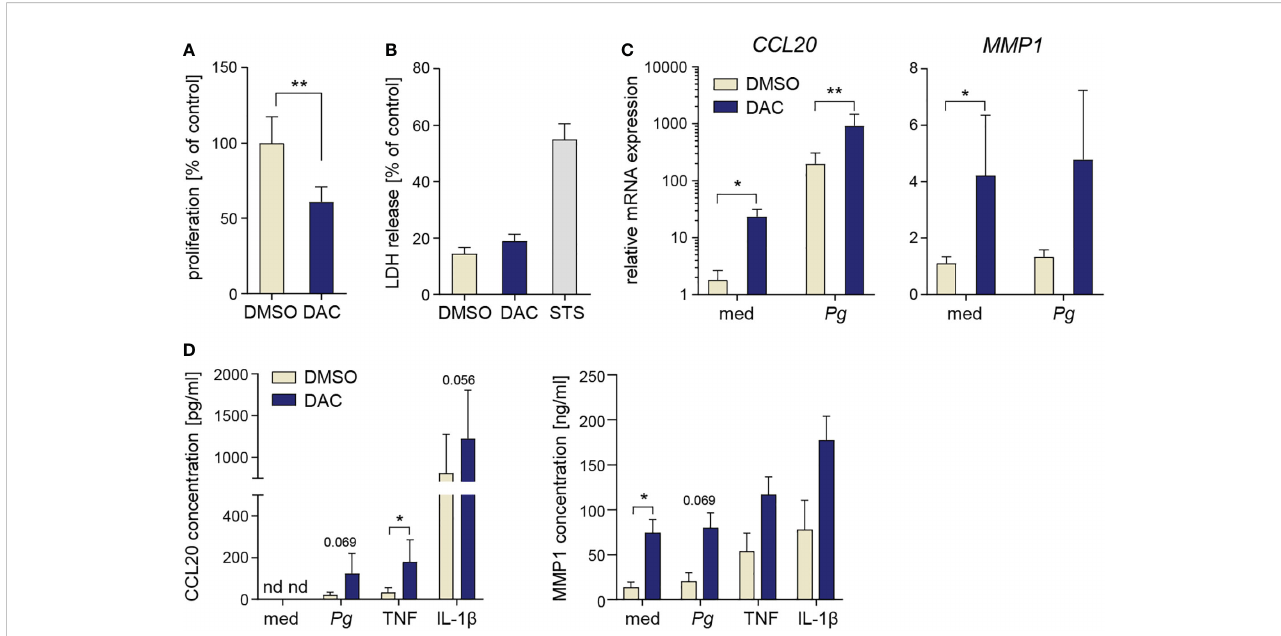
FIGURE 6 DAC has anti-proliferative and pro-in fl ammatory effects on PDLFs. (A) Proliferation rate (n=5) and (B) LDH release (n=4) in PDLFs treated with DMSO or DAC for 12 days. (C) qPCR analysis of CCL20 and MMP1 mRNA expression in PDLFs (n=5) treated with DMSO or DAC for 12 days prior to infection with P. gingivalis ( Pg , MOI 20) for 4 h; ‘ med ’ refers to uninfected control. (D) CCL20 and MMP1 production by DMSO- or DAC-treated PDLFs that were infected with P. gingivalis (MOI 50) for 1 h followed by 23 h of culture in fresh medium, or were stimulated with TNF or IL-1 b (both at 10 ng/ml) for 24 h (n=4). nd, not detectable; *P < 0.05, **P <